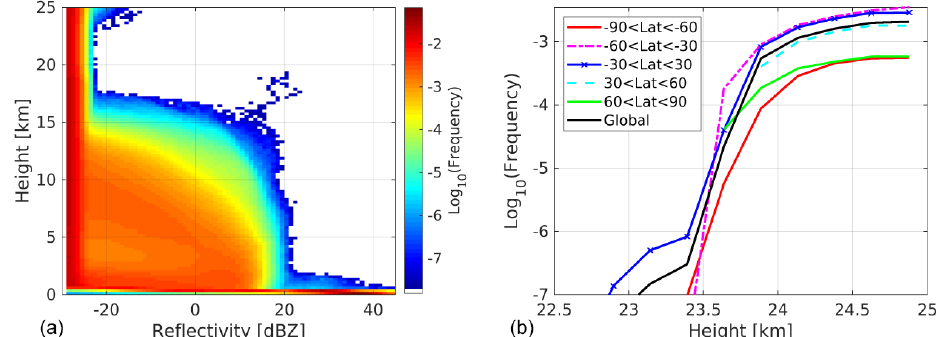
Figure 3. (a) CFAD of CloudSat reflectivities over the ice-free ocean with no convection for 2008. The anomalous presence of clouds between 23 and 25km with reflectivities between − 28 and − 20dBZ is due to second-trip echoes associated with mirror images. (b) Frequency of second-trip echoes above 22km for different latitudinal bands derived from the CFAD subtracting the “noise floor” as computed by averaging altitudes between 19.5 and 20.75km.